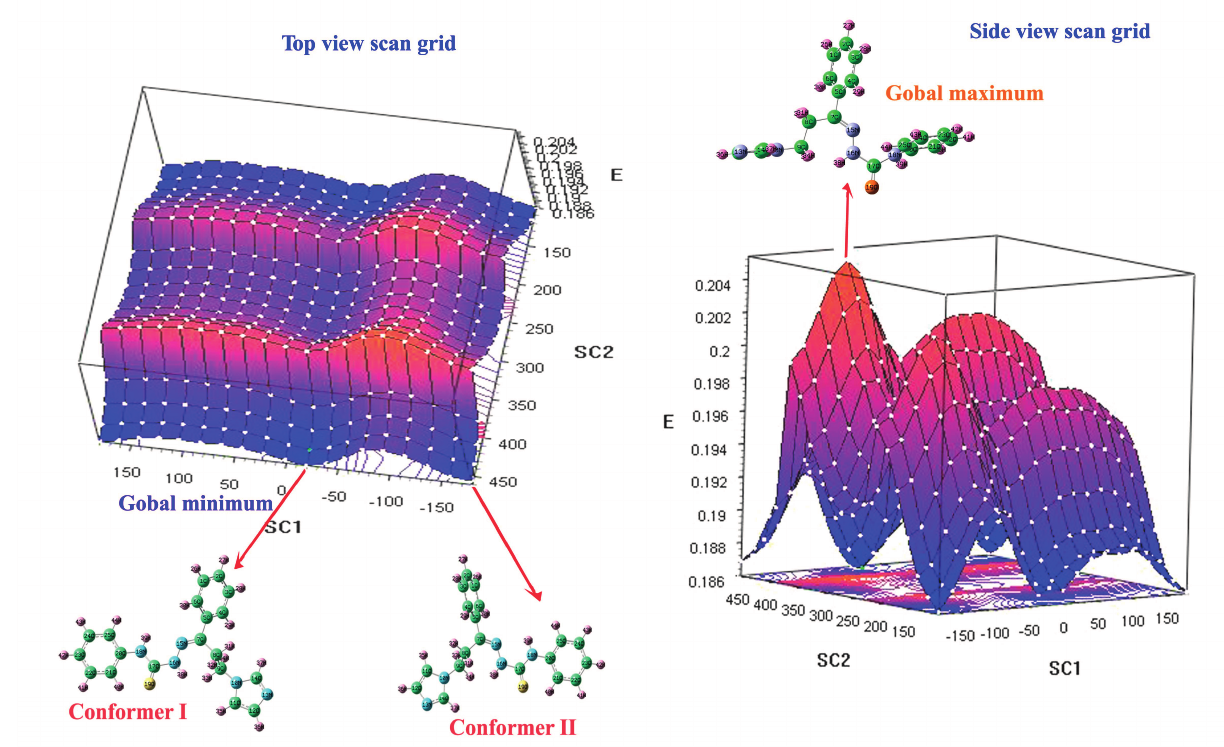
Figure 1. Potential energy surface grid of (2 E